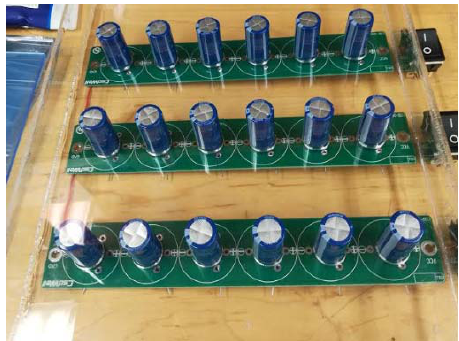
Figure 11. Ultracapacitors used in the electric test bench.